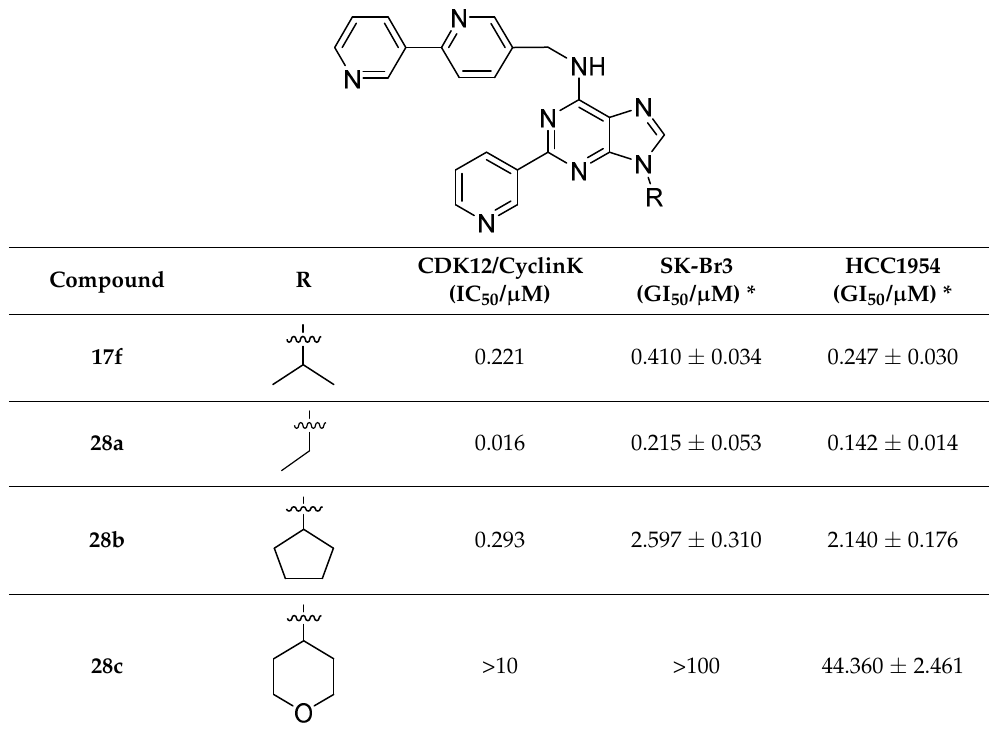
Table 4. Structure-activity relationship for derivatization at 9 position.